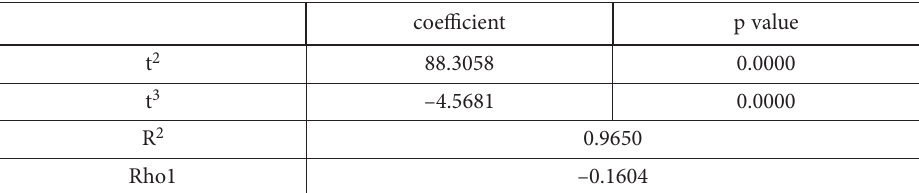
Table 6. The trend model of the bankruptcy in Slovakia in the years 2005–2016 (source: Own work) coefficient p value const 2717.4100